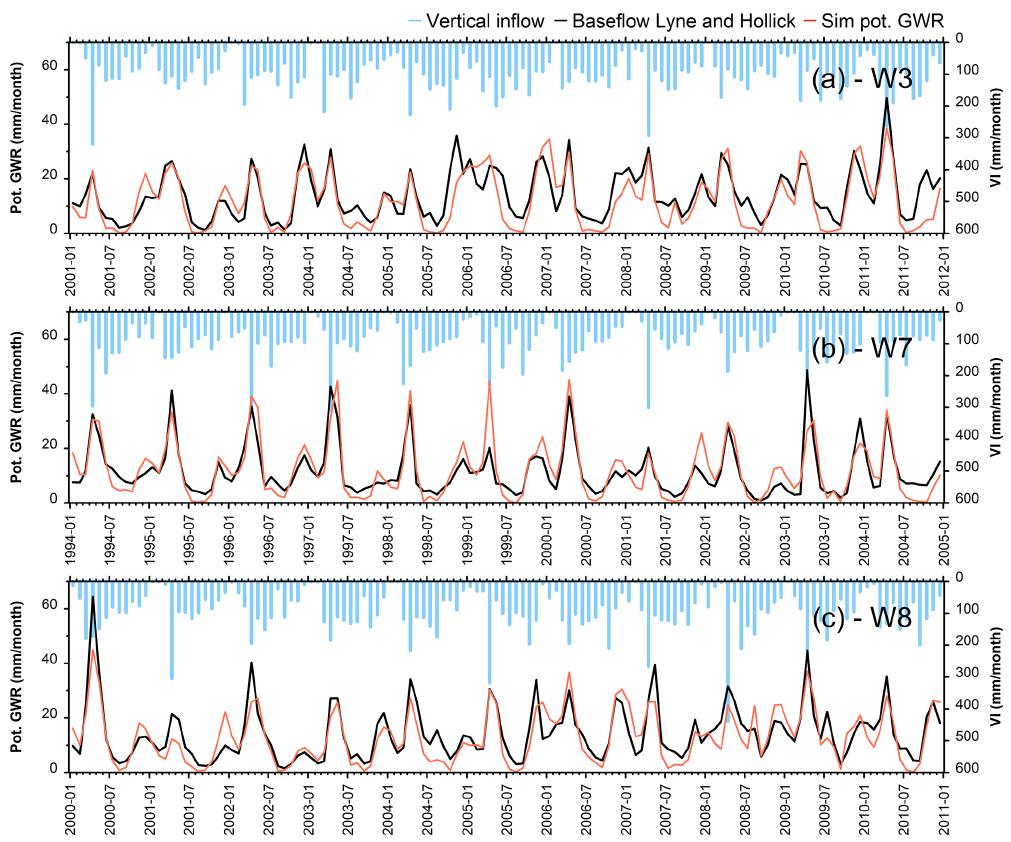
Figure 5. Examples of simulated monthly potential groundwater recharge (GWR) and baseflows estimated with the Lyne and Hollick (1979) filter for the downstream gauging stations of W3 (a) , W7 (b) , and W8 (c)